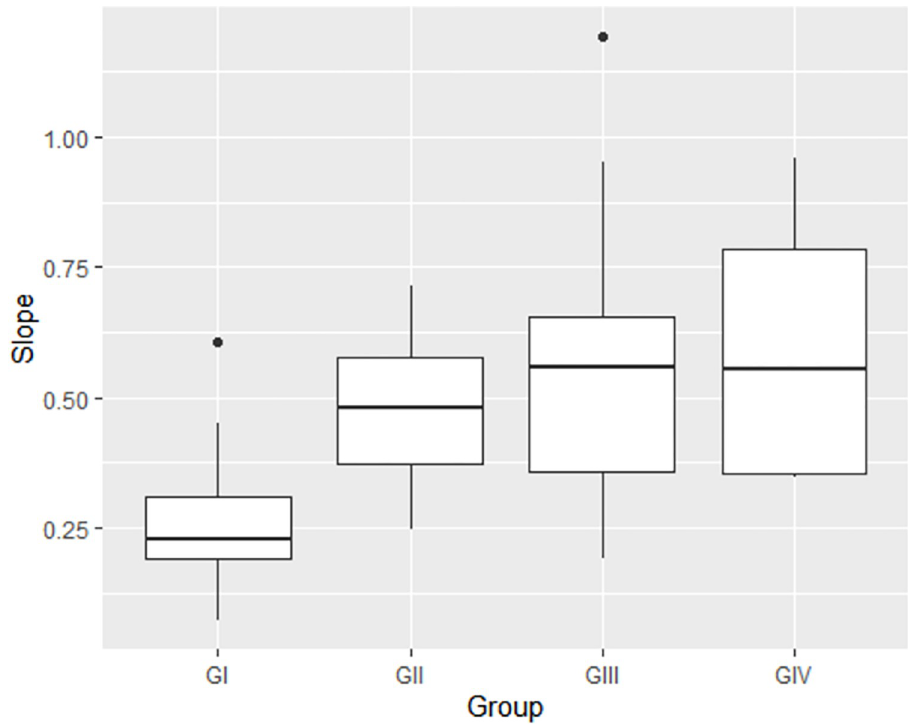
Fig 2. Boxplot of the slope distribution in function of age groups. GI = newborns; GII = infants; GIII = preschool children; GIV = school aged children. P-value = 0.000; Adj. R 2 = 0.401.